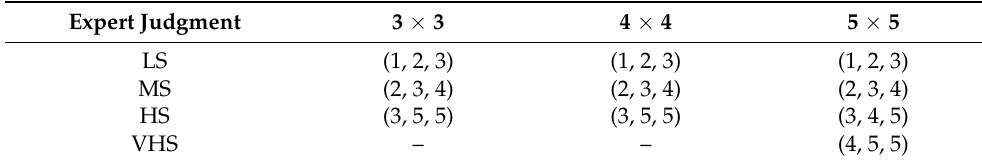
Table 2. Fuzzy membership of severity classes determined by expert